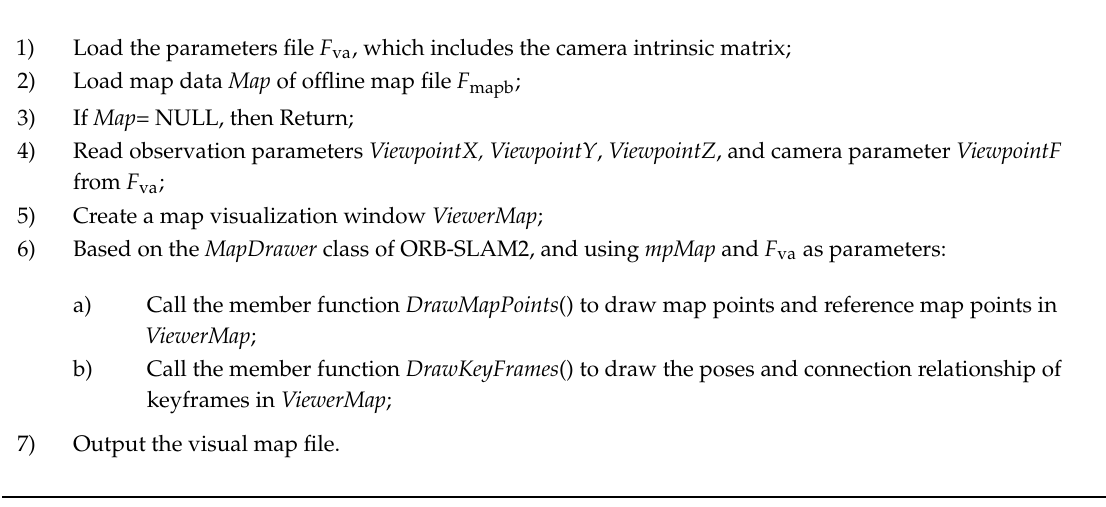
Algorithm 5: Offline visualization method of map elements